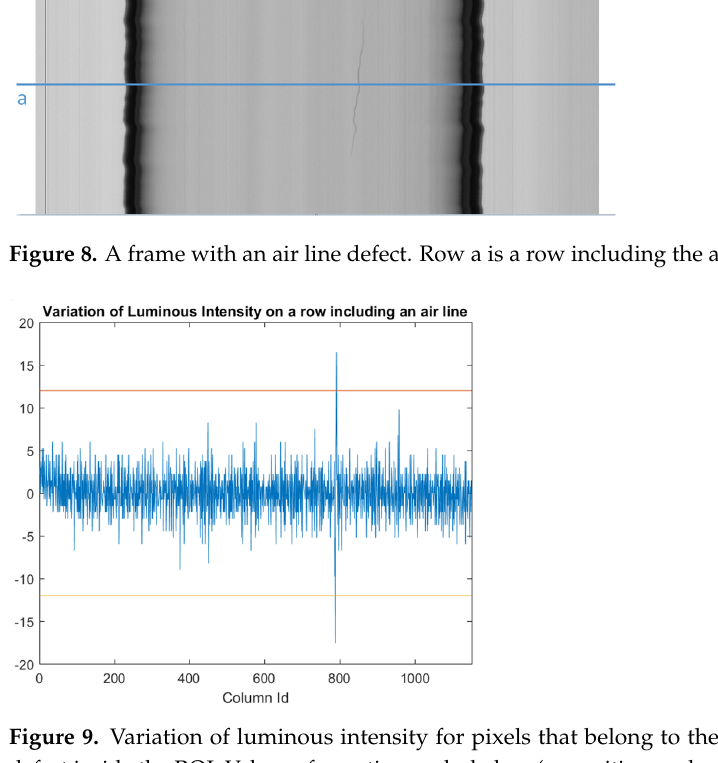
Figure 9. Variation of luminous intensity for pixels that belong to the same row with an air line defect inside the ROI. Values of negative peaks below (or positive peaks over) a given threshold may represent the air line defects.